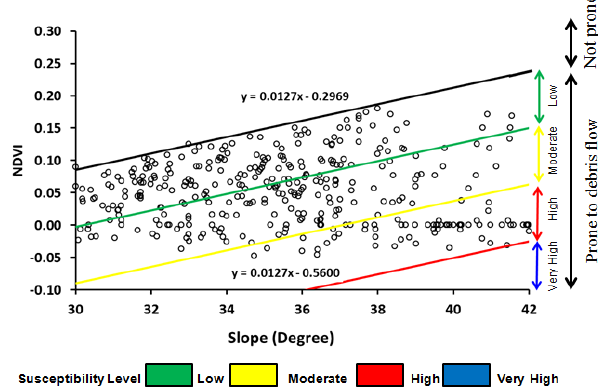
Figure 5. NDVI versus slope values for the debris flows that were verified in the field and/or by examination of Google Earth images. Also shown is a regression line that separates points prone to land- slide (below line) from others that are not prone to debris flows (above line) and susceptibility levels expressed as a function of dis- tance from the regression